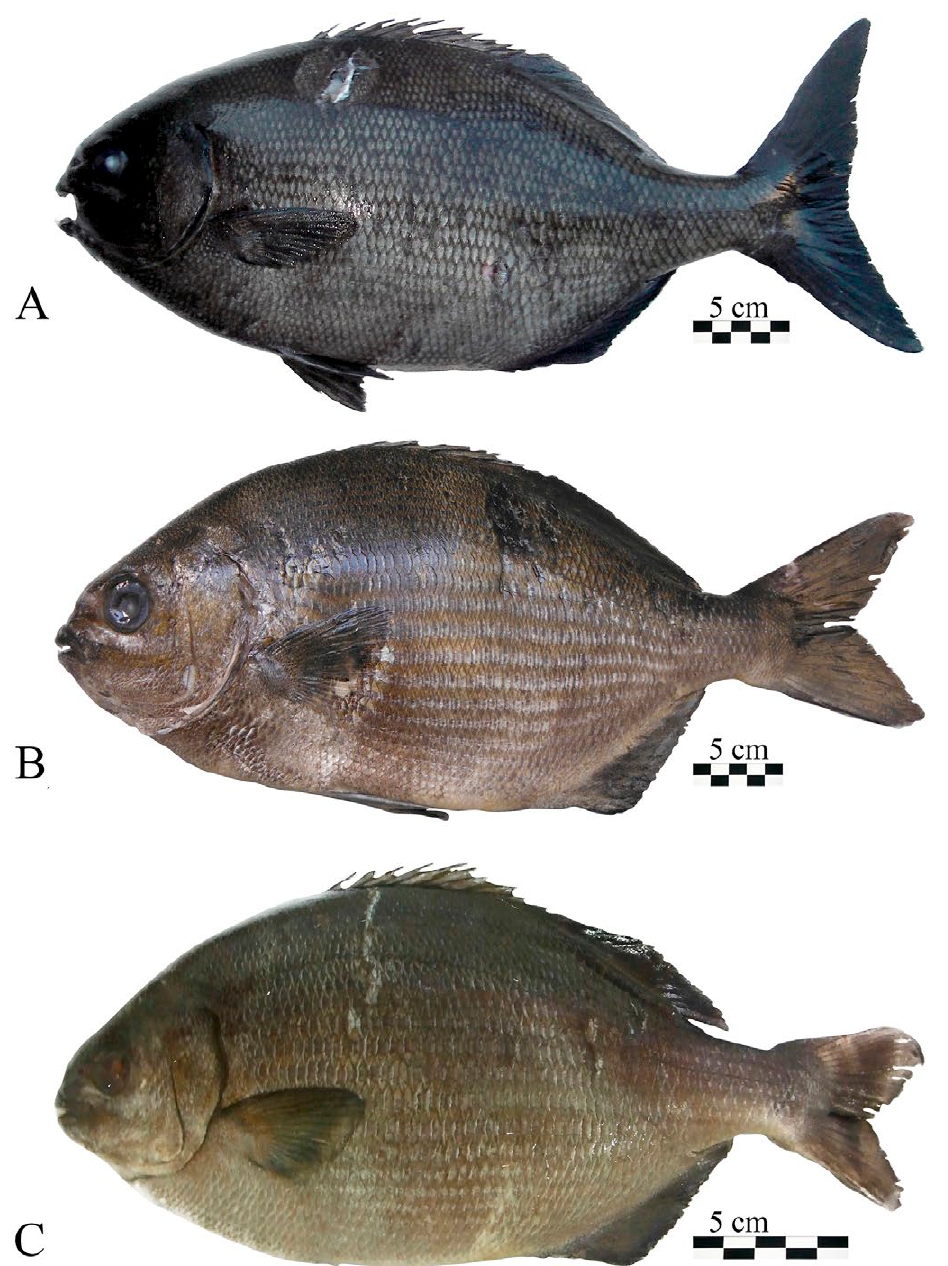
Fig. 1. – Kyphosus specimens caught in Galician waters: K. sectatrix , MHNUSC 25018-1, 450 mm total length (A); K. vaigiensis , MHNUSC 25017-1, 482 mm total length (B); K. vaigiensis, MHNUSC 25017-2, 280 mm total length